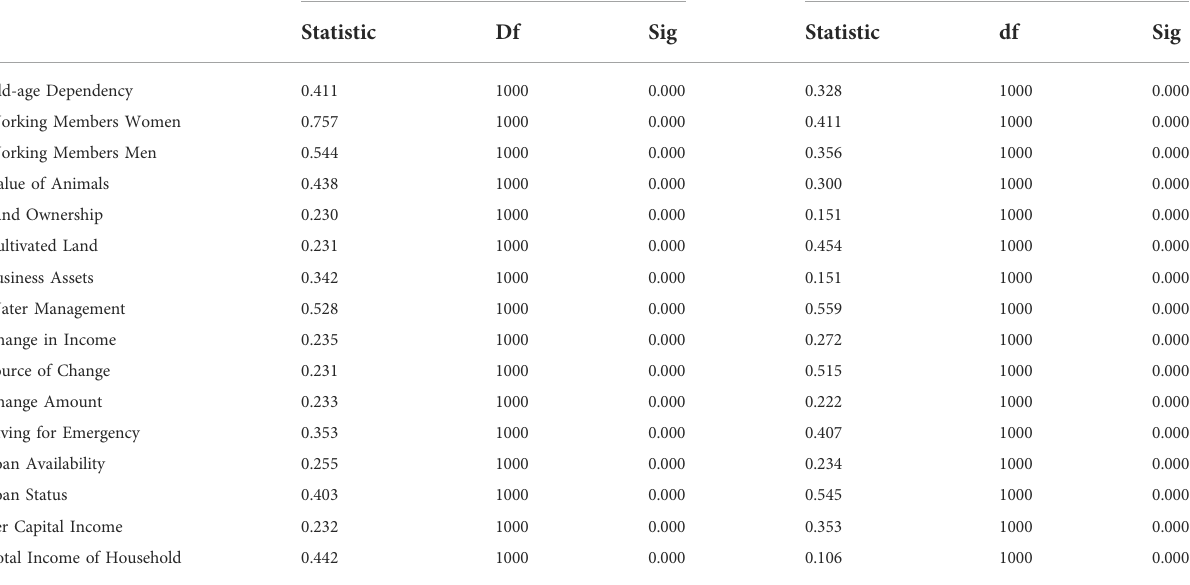
TABLE 1 Normality test results.